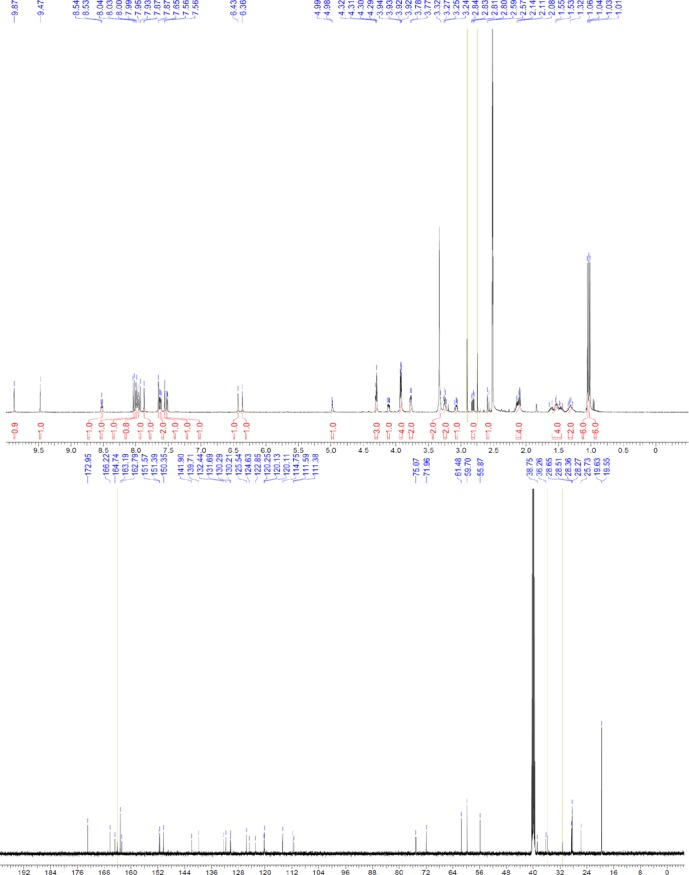
1H and 13C NMR of compound ERX-11-biotin.